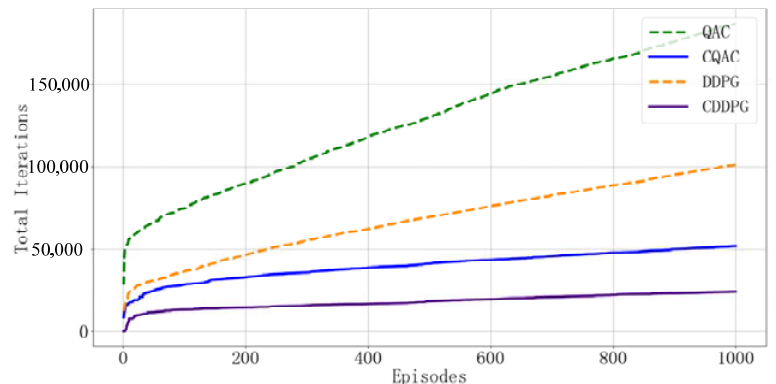
Figure 9. Total iterations of four algorithms.